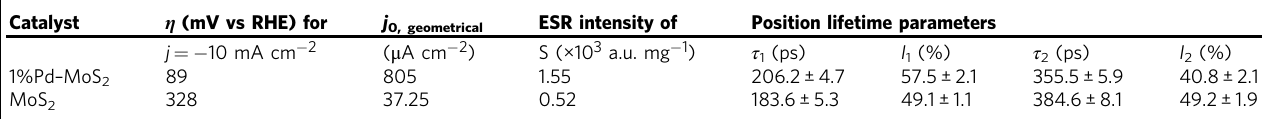
Table 1 Summary of the electrochemical and structural properties of 1%Pd – MoS 2 and MoS 2 catalysts